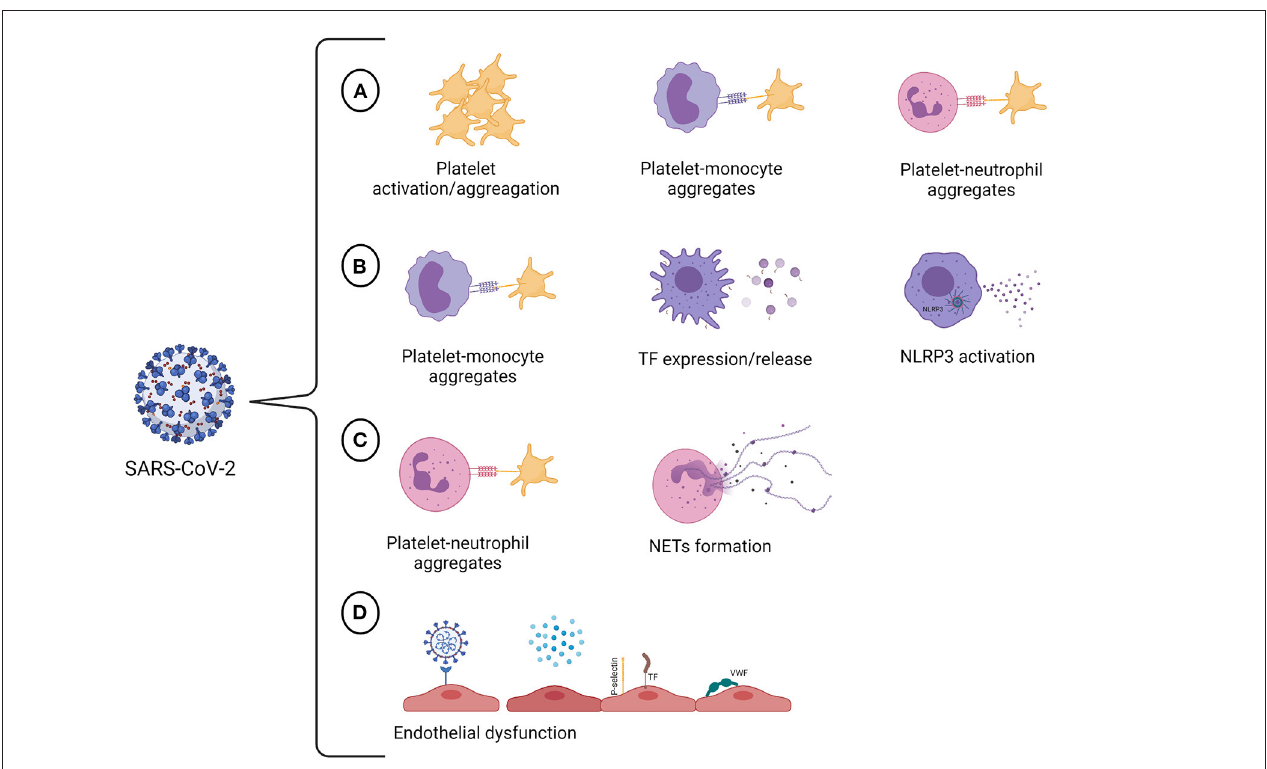
FIGURE 1 | SARS-CoV-2 targets multiple vascular cells. (A) SARS-CoV-2 infection promotes hyperactivation of platelets. The consequences of platelet activation include reorganization of the platelet membrane, which enables fibrinogen binding and allows platelet aggregation, and the translocation of P-selectin to the platelet surface, enabling the formation of platelet-monocyte and platelet-neutrophil aggregates. (B) The crosstalk between platelets and monocytes can upregulate TF expression and release by monocytes, giving these cells a procoagulant phenotype. The infection of human monocytes with SARS-CoV-2 may activate the NLRP3 inflammasome, leading to an increase in procaspase-1 cleavage and IL-1 β production and, therefore, resulting in a hypercoagulable state. (C) The interactions between neutrophils and platelets at sites of inflammation facilitate NET formation. It has also been proved that SARS-CoV-2 can induce NET formation in healthy neutrophils in vitro . NETs can propagate thrombus formation due to their thrombogenic properties, including the ability to initiate the intrinsic pathway of coagulation, to degrade natural coagulation inhibitors, and exert antifibrinolytic effects. (D) COVID-19 may trigger endothelial cell dysfunction either due to SARS-CoV-2 infection of endothelial cells or by pro-inflammatory cytokines that are produced in response to viral infection. The activation of endothelial cells results in the loss of the antithrombotic phenotype of the endothelium, occasioning the activation of the coagulation cascade, platelets and complement system in the vasculature. Created with